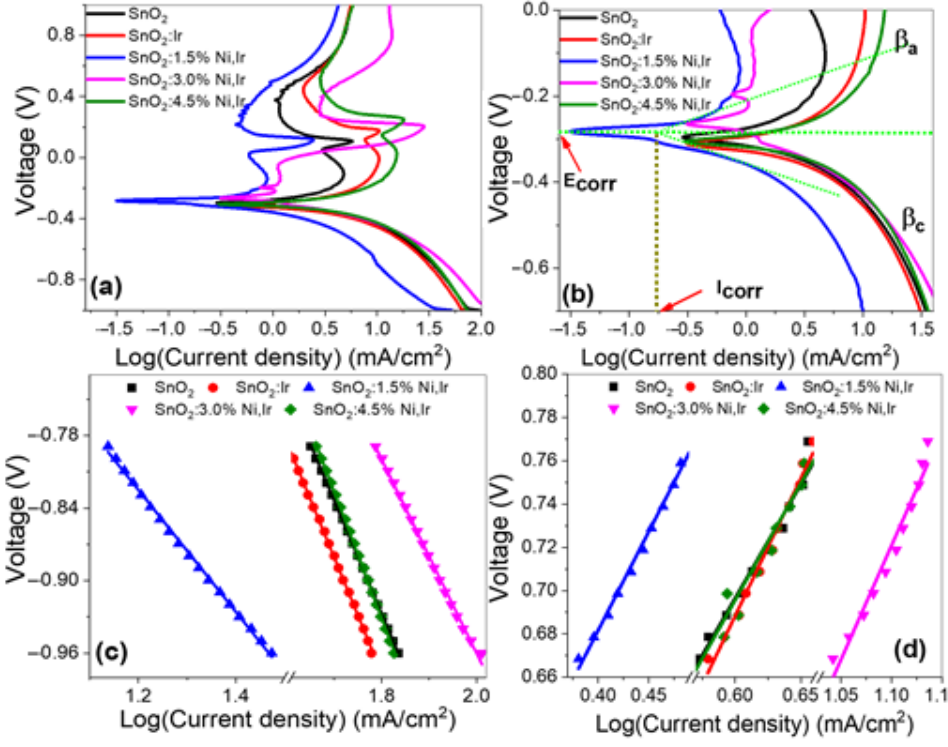
Figure 10. ( a , b ) Combined anodic and cathodic Tafel plots of all photoelectrodes provided with the characteristic parameters. Calculation of cathodic slopes ( βc ) ( c ) and anodic slopes ( d ). For all electrodes, the determined values of E corr , I corr , β a, and β c are listed in Table 3. Table 3. Values of corrosion and Tafel parameters, and ECSA of our The β a and β c values are raised by adding 3% Ir to reach 125.2 and 95.9 mV/dec and then decreased by co-doping with 1.5% Ni to 90.4 and 50.4 mV/dec, respectively, whereas their values are increased to 105.8 and 104.1 mV/dec, respectively, by increasing the Ni content to 4.5%. Tafel PEC slopes clarify what the reactions mechanisms and rate-limiting stages are in the PEC process. That is, the Volmer–Tafel mechanism is dominant when the re- combination stage is rate-limiting, and the Tafel slope is ~30 mV/decade. The Volmer–